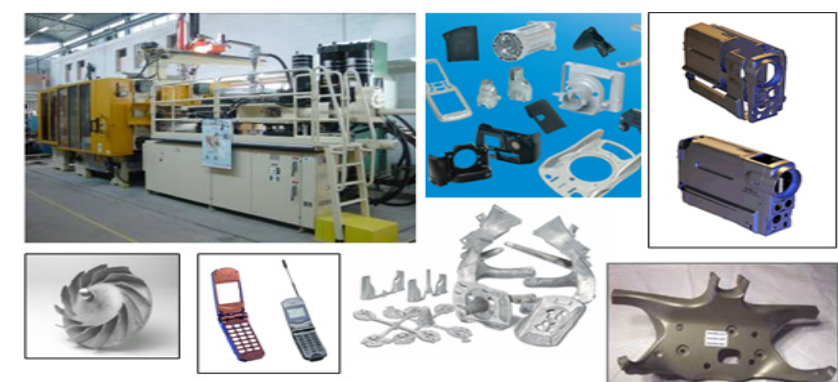
Figure 7 – Plant for Thixomoulding procedure with manufactured